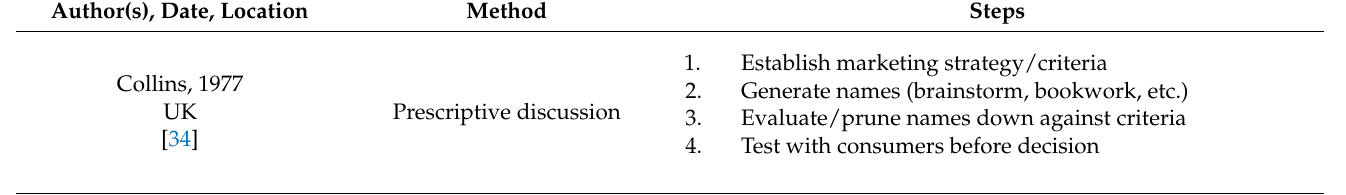
Table 1. Previous research of the brand name development